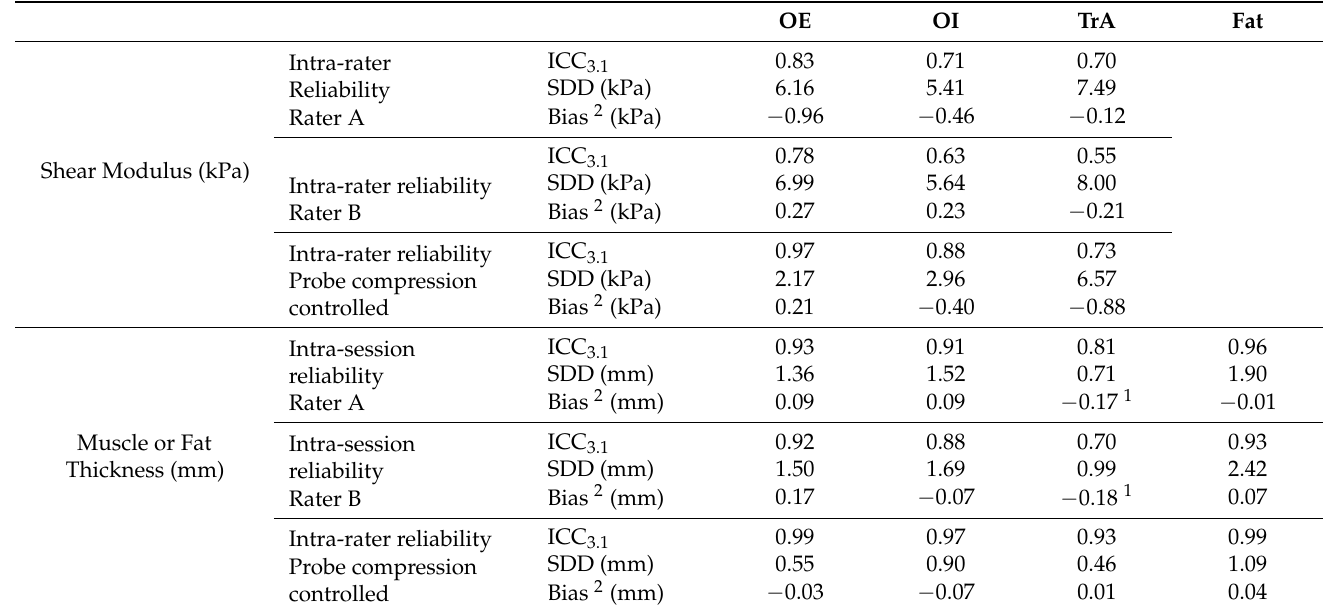
Table 1. Reliability and validity of elasticity and thickness values of oblique external (OE), oblique internal (OI), and transversus abdominis (TrA) muscles in supine rest